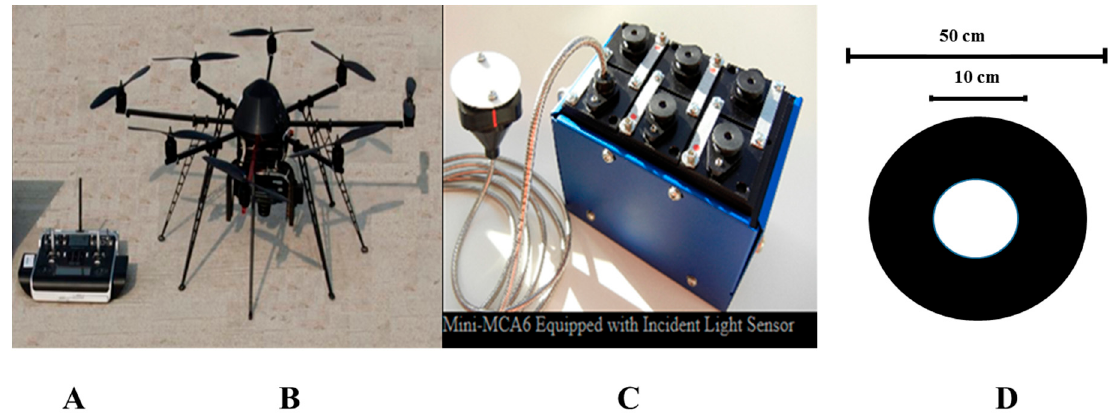
Figure 2. The UAV and sensor ( A ) Graupner MC-32, ( B ) ARF-MikroKopter UAV, ( C ) Multispectral sensor, ( D ) Ground control point.